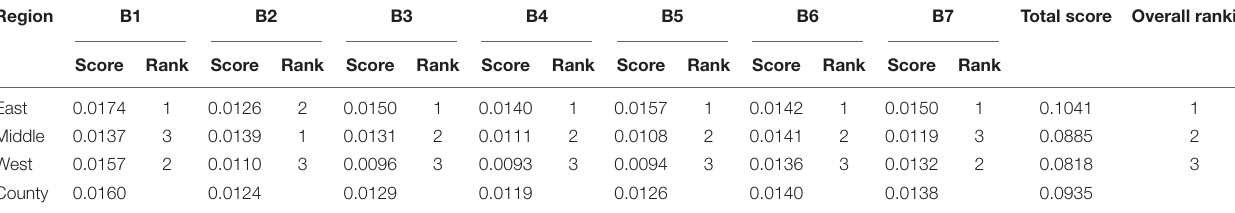
TABLE 2 | 2011–2015 social development level scores of the three regions.